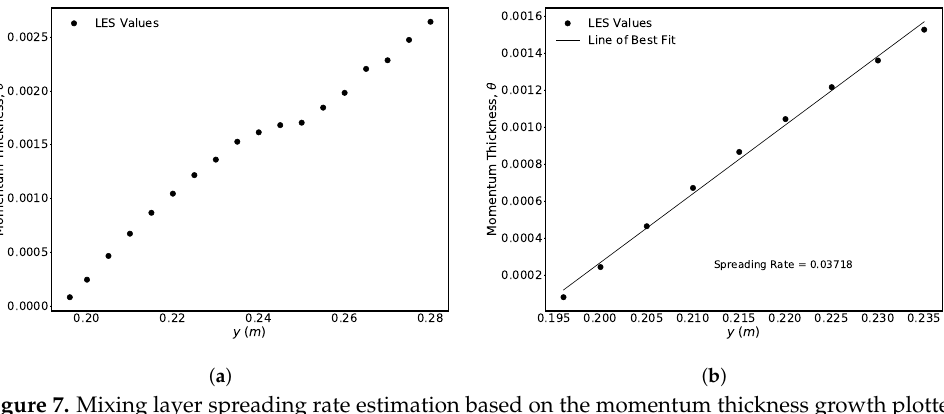
Figure 7. Mixing layer spreading rate estimation based on the momentum thickness growth plotted over a streamwise distance covering the initial linear region and extending into the region where three- dimensional effects are expected to become significant as the axisymmetric shear layer transitions into an axisymmetric jet. In ( b ), a line of best fit is inserted through the strongly linear initial mixing layer phase up to approximately Y / D orifice ≈ 5, yielding the spreading rate SR θ = 0.03718. ( a ) Points up to Y / D orifice ≈ 9. ( b ) Points up to Y / D orifice ≈